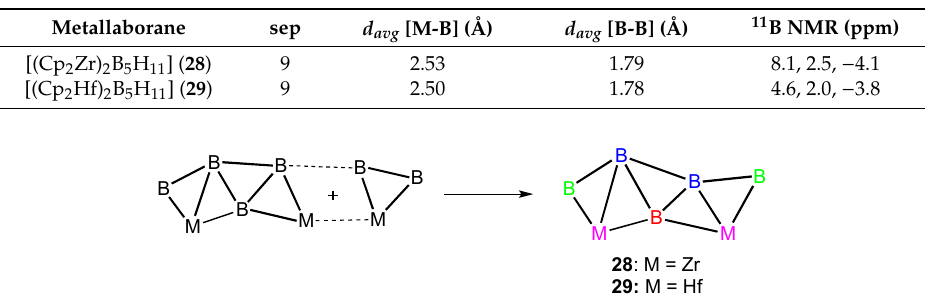
Figure 11. Generation of the core structure of compounds 28 and 29 from cluster fusion. Table 6. Skeletal electron pair count (sep), selected structural parameters, and 11 B chemical shifts of 28 and 2 9 of type IV .